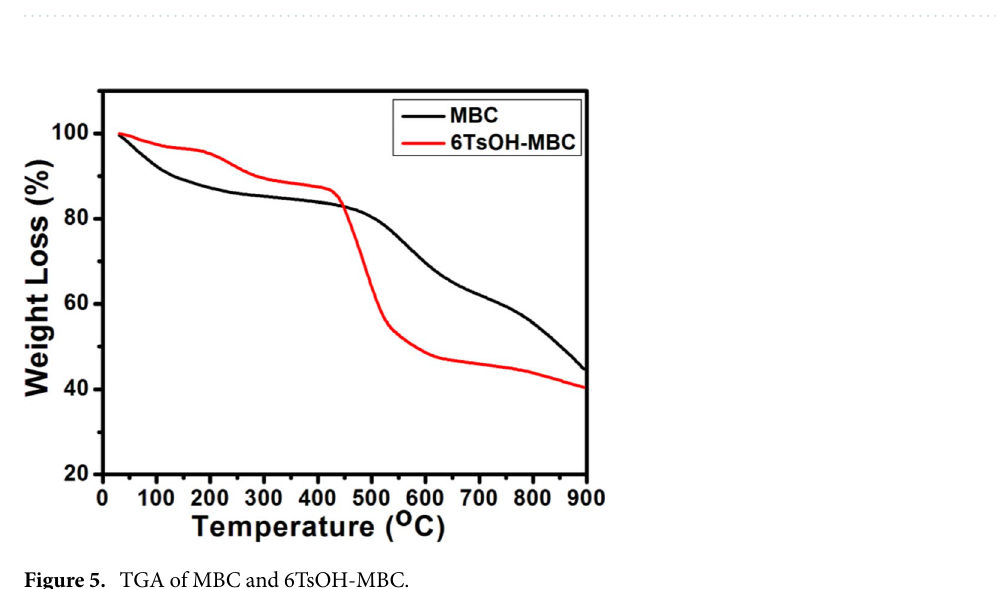
Table 1. EDX analysis for MBC and 6TsOH-MBC catalyst.